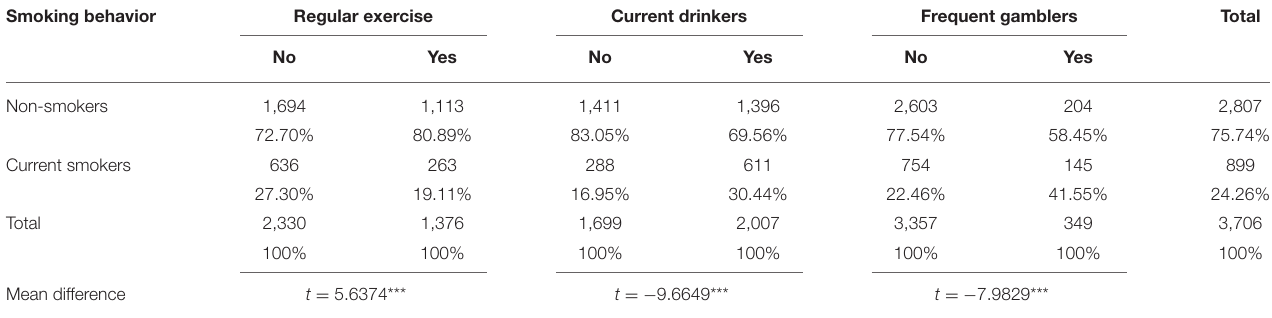
TABLE 5 | Distribution of smoking behavior by risky